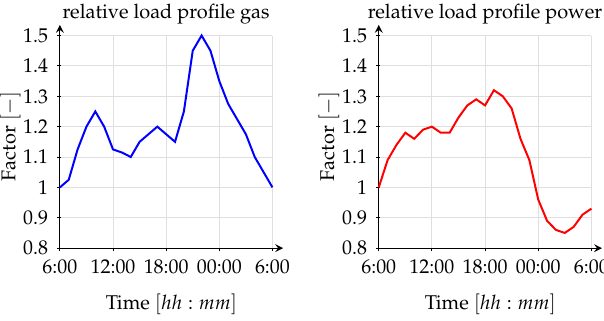
Figure 5. Load profiles gas ( left side) and power ( right side) networks.